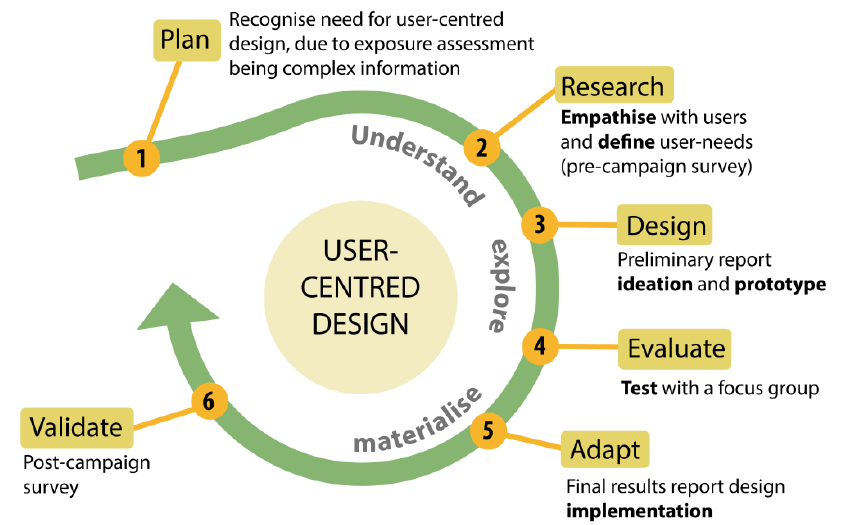
Figure 1. A life-cycle model of the UCD results report in the ICARUS multi-sensor personal expo- sure campaign.